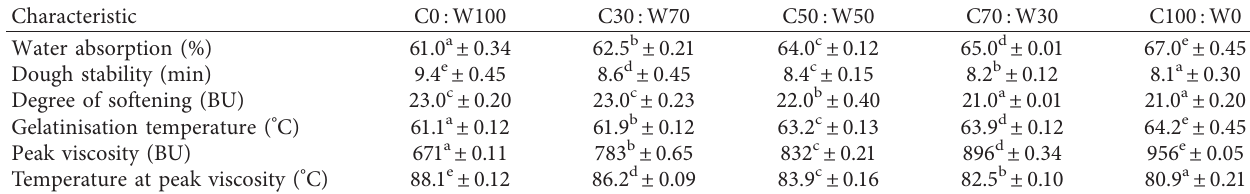
Table 3: Rheological properties of wheat dough samples with different concentrations of camel